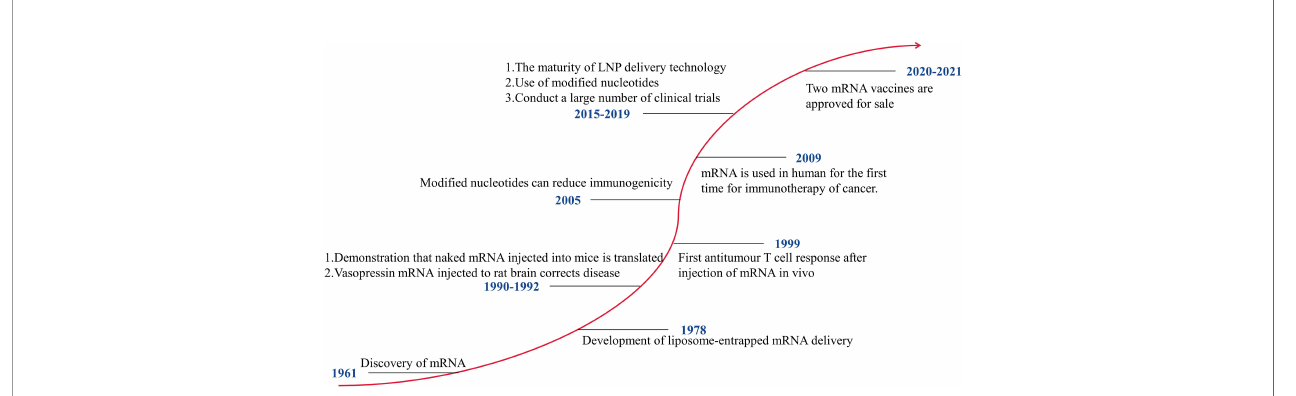
FIGURE 1 | The Development of mRNA